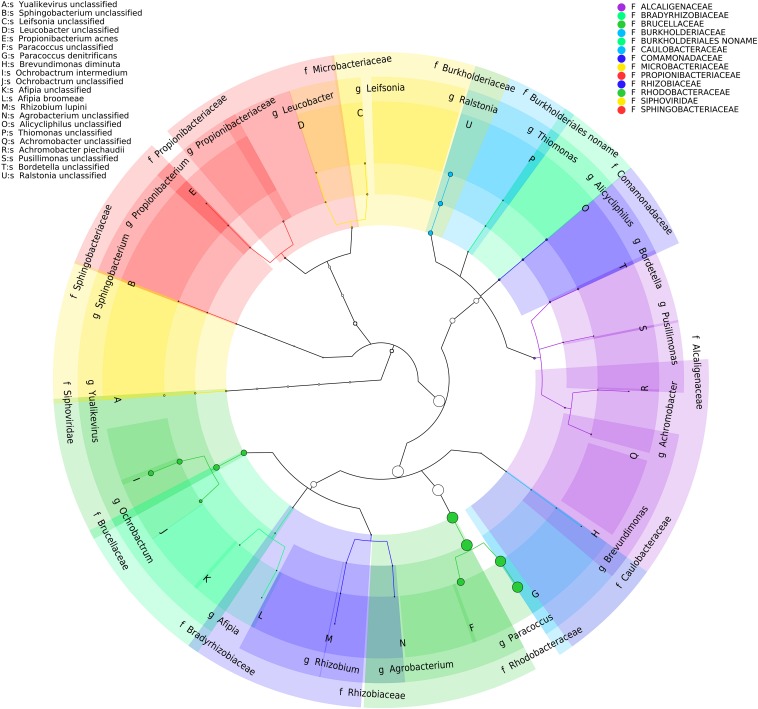
Taxonomic cladogram of BP8 community microbial diversity profiled with MetaPhlAn. Circles size is proportional to the taxon relative abundance. The most abundant taxa were Paracoccus genus (83%) and Ochrobactrum genus (8.7%). Families are color-labeled and predicted species diversity is indicated by capital letters (Asnicar et al., 2015).